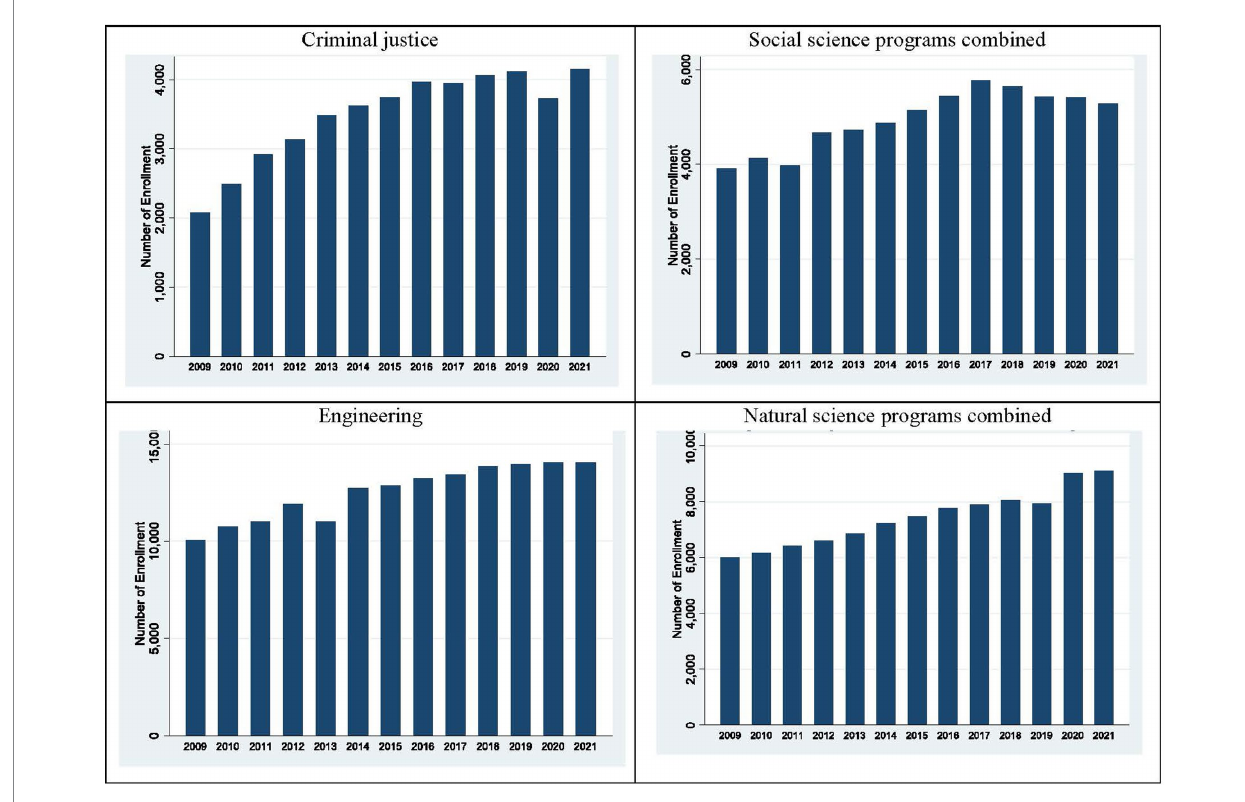
FIGURE 1 Enrollment count trends from 2009 to 2021 for each individual program type.